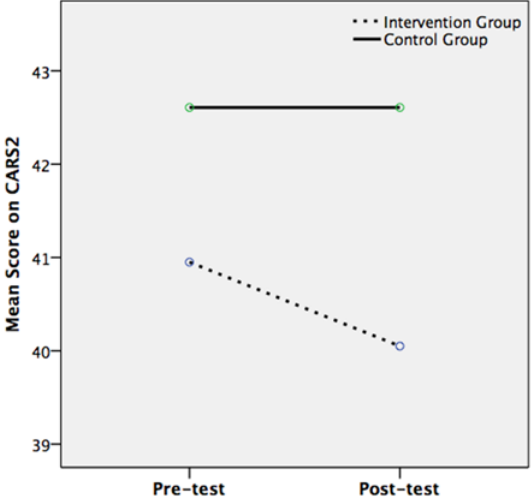
Figure 1. Mean Childhood Autism Rating Scale, Second Edition (CARS2) scores at pre- and post-test for the intervention group ( n = 10) and control group ( n = 14).